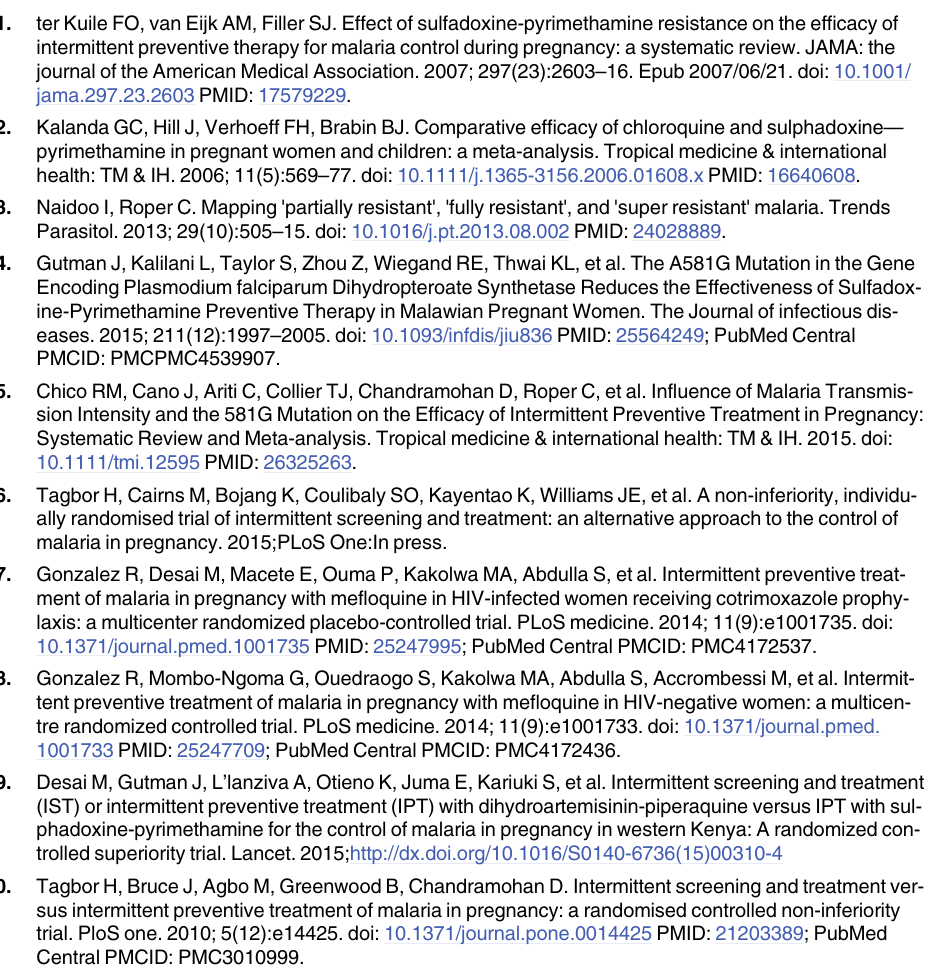
S3 Table. Health provider and trial staff perspectives in the context of the trial and implica- tions for